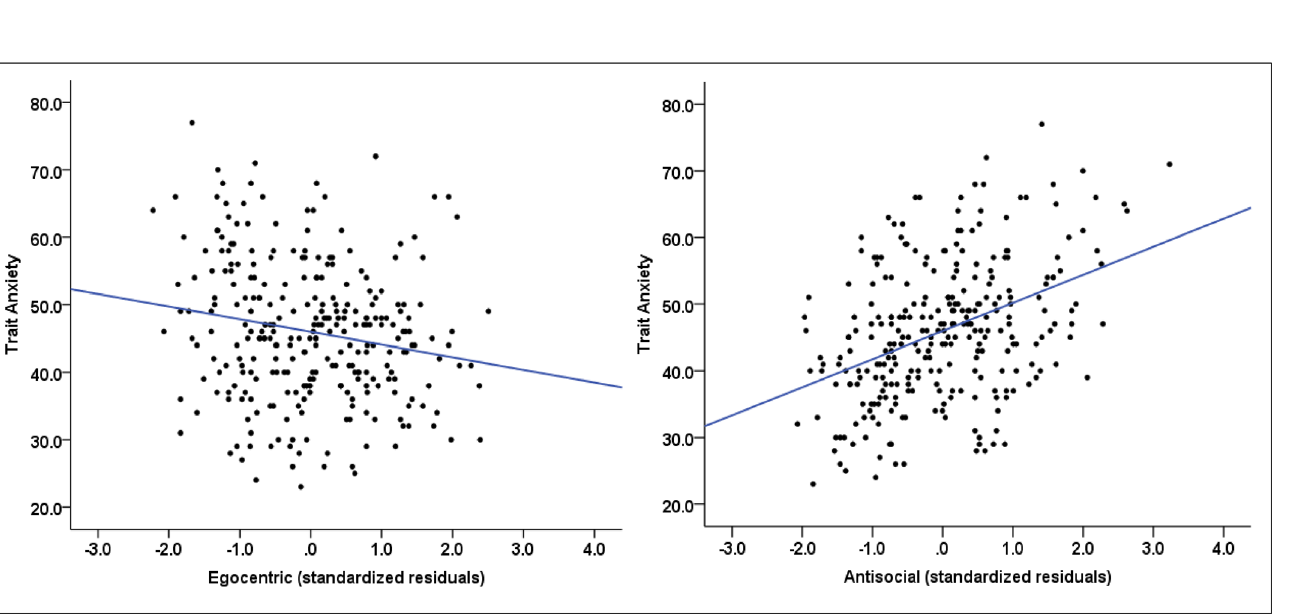
Fig 1. Scatter plots showing the relationship of (left) egocentric, and (right) antisocial psychopathic traits with trait anxiety in the full sample.